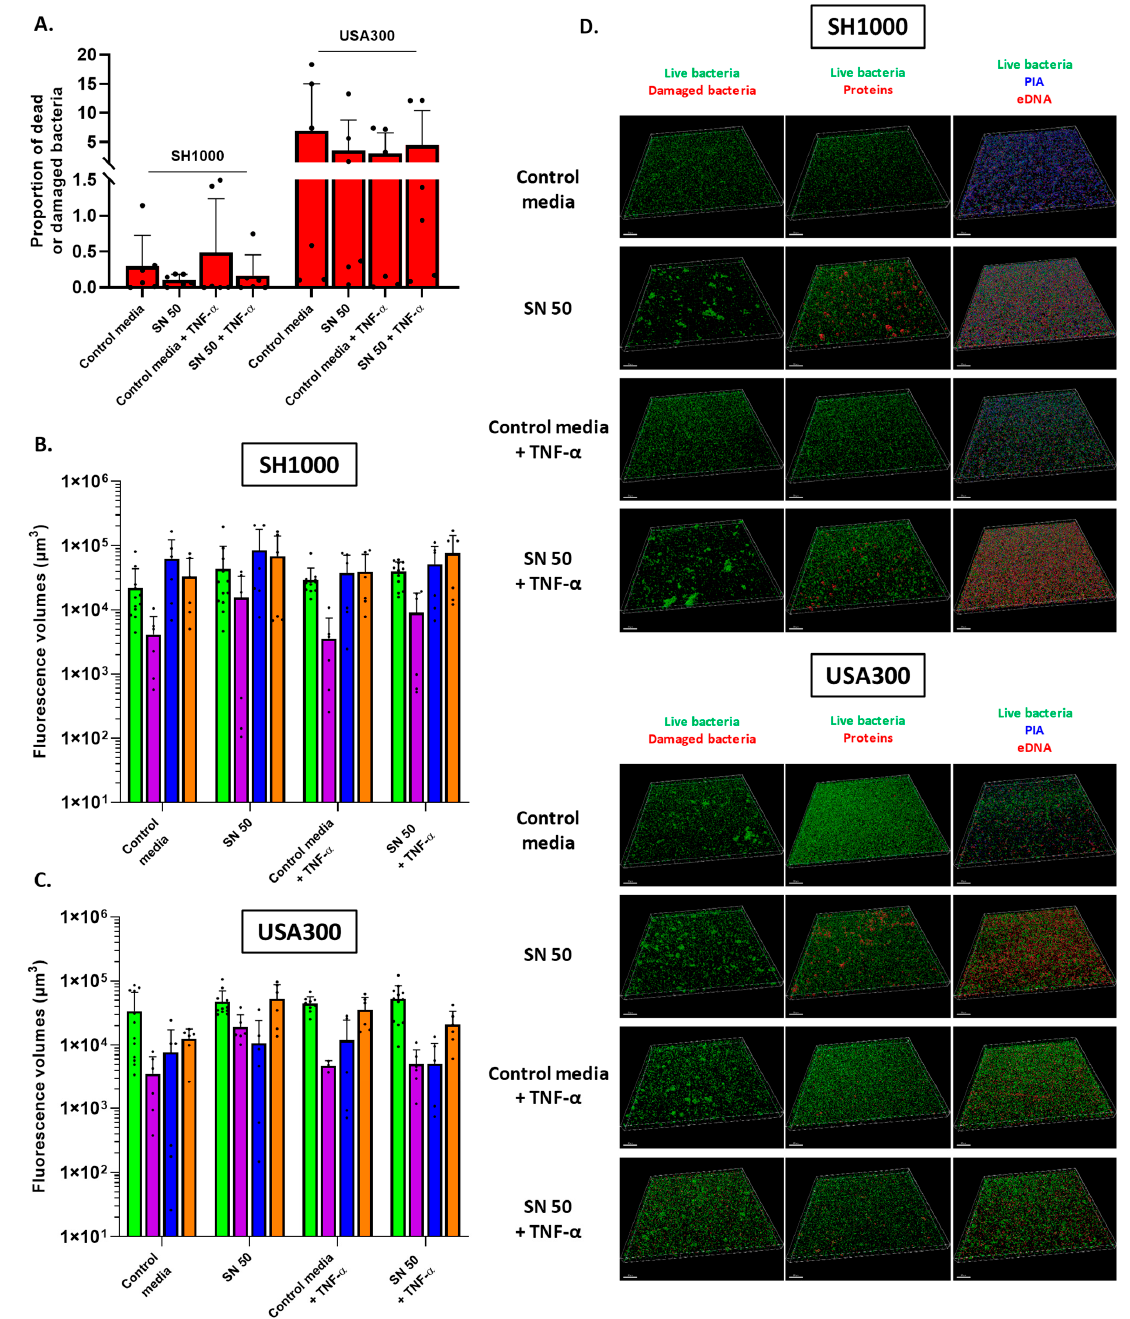
Figure 4. Impact of Saos-2 culture supernatant on proportion of dead cells and biofilm matrix components of S. aureus . ( A ) Proportion of dead or damaged bacteria; volume measurement of SYTO TM 9 and propidium iodide were acquired by CLSM. ( B , C ) Volume measurement of SYTO TM 9 (green histograms, live bacteria), SYPRO ® Ruby (purple, protein), WGA (blue, PIA), and TOTO TM - 3 (orange, extracellular DNA) acquired by CLSM for SH1000 and USA300 biofilms, respectively. ( D ) Representative reconstructions of S. aureus biofilms are shown. Above each column is indicated the labelled component and the corresponding colour. The scale bars indicate 50 µ m. Control media (50% [DMEM + 10% FBS] and 50% MM), SN 50 (50% Saos-2 culture supernatant and 50% MM), Control media + TNF- α (50% [DMEM + 10% FBS + 20 ng/mL TNF- α ] and 50% MM), or SN 50 + TNF- α (50% [Saos-2 challenged with TNF- α culture supernatant + 20 ng/mL] and 50% MM). n = 2 with three acquisitions per coverslip; dots represent technical replicates for this